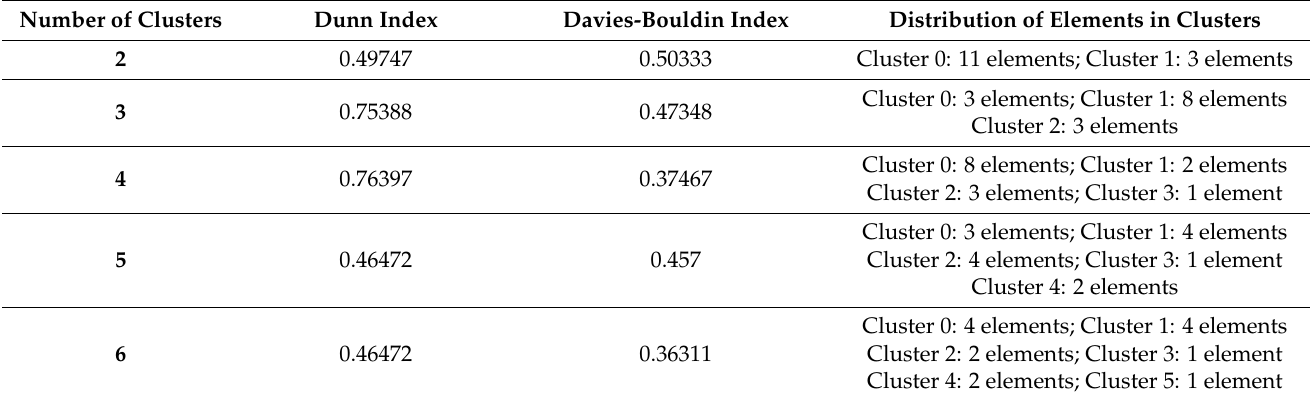
Table 4. Dunn index and Davies-Bouldin index values for Agglomerative Hierarchical Clustering.